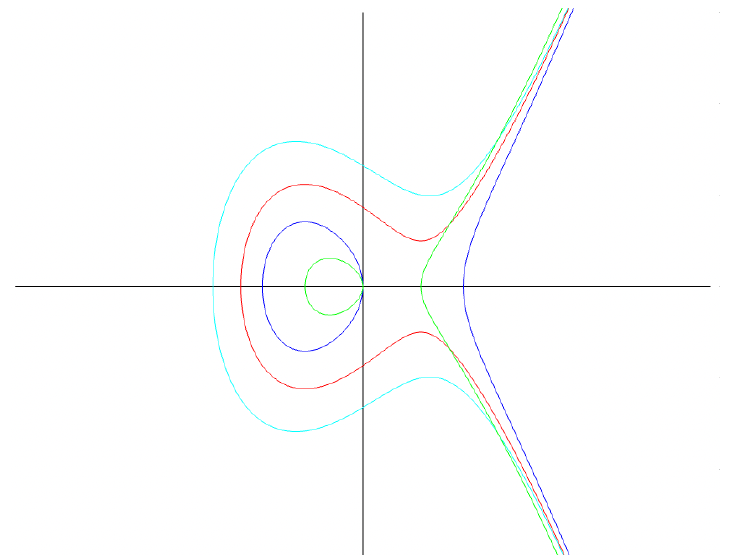
Figure 2. Series of elliptic curves.